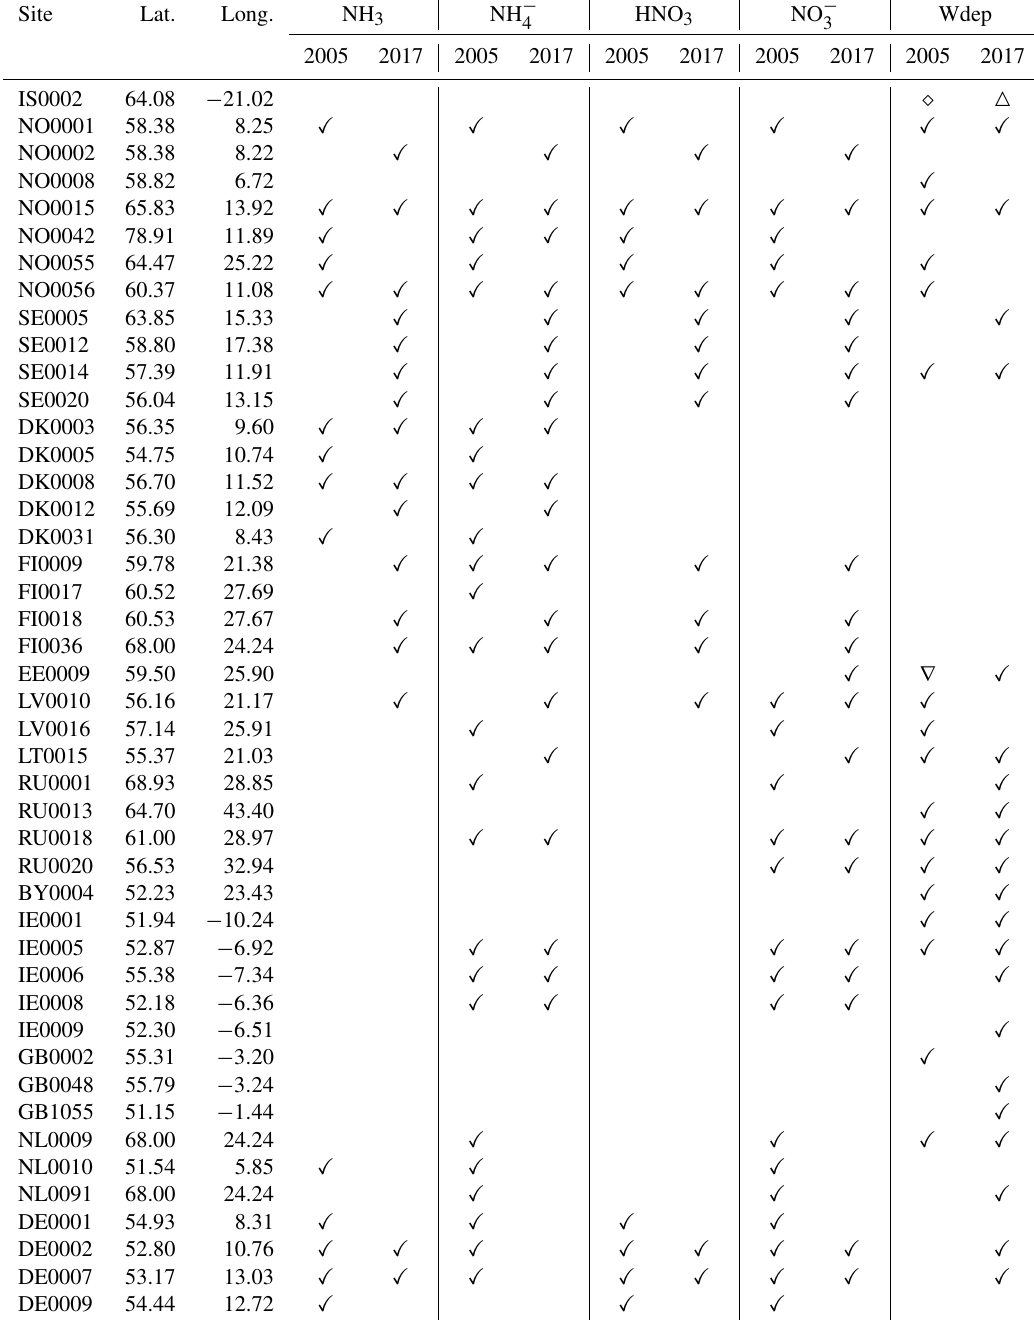
Table A2. List of sites included in scatter plots in Figs. A1 to A4. Wet depositions when included for all three species (reduced nitrogen, oxidised nitrogen, and oxidised sulfur) are marked with (cid:88) . Only reduced and oxidised nitrogen marked with ∇ , only oxidised N and S marked with (cid:52) , only reduced N and oxidised S marked with • , and only oxidised sulfur marked with (cid:5) . Site